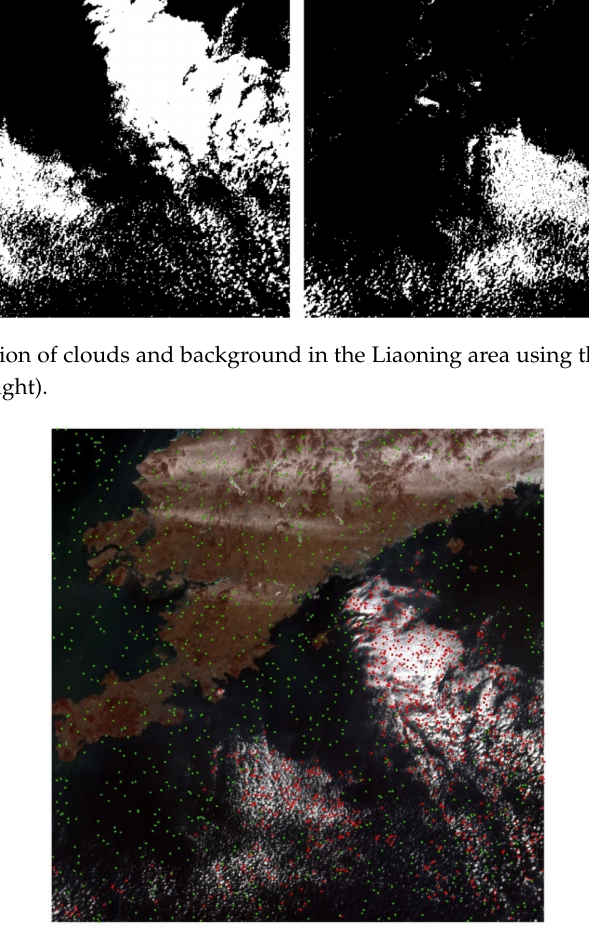
Figure 8. The 2000 points obtained using stratified random sampling from the Liaoning study area that